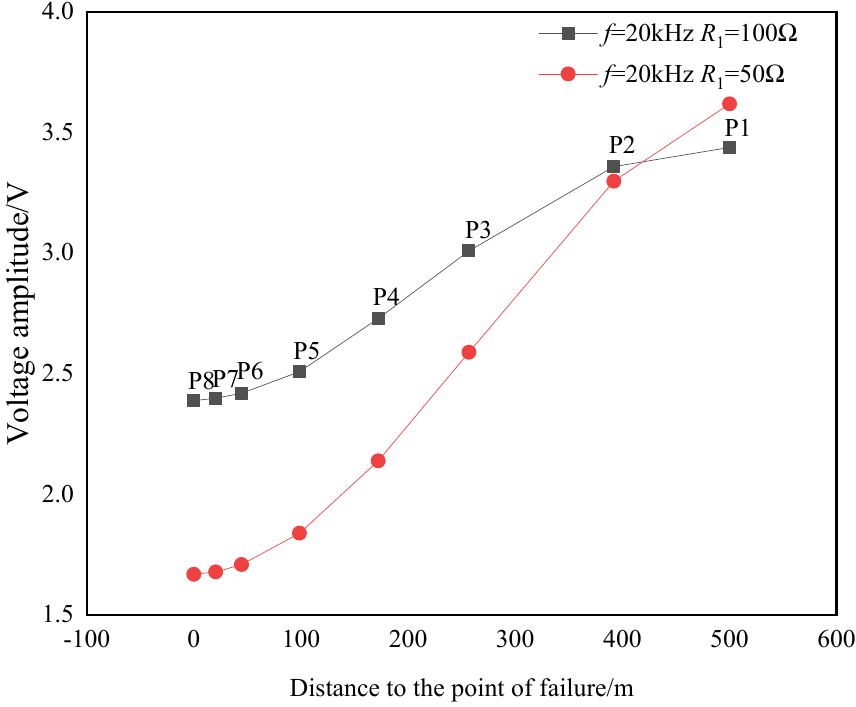
Figure 11. Actual data distribution of different ground resistance faults. Corresponding with detection point P8 to detection point P3 in Figure 11 is a cable from small to large. There is a 135 m-long cable between the detection point P3 and the detection point P2; between the detection point P2 and the detection point P1 is a 108 m- long cable. The 0 point on the horizontal axis is the fault point. It can be seen from the figure that the voltage amplitude of the fault point is not 0 when the fault resistance R 1 is equal to 100 Ω and R 1 is equal to 50 Ω , and it shows an upward trend as the distance from the fault point increases.